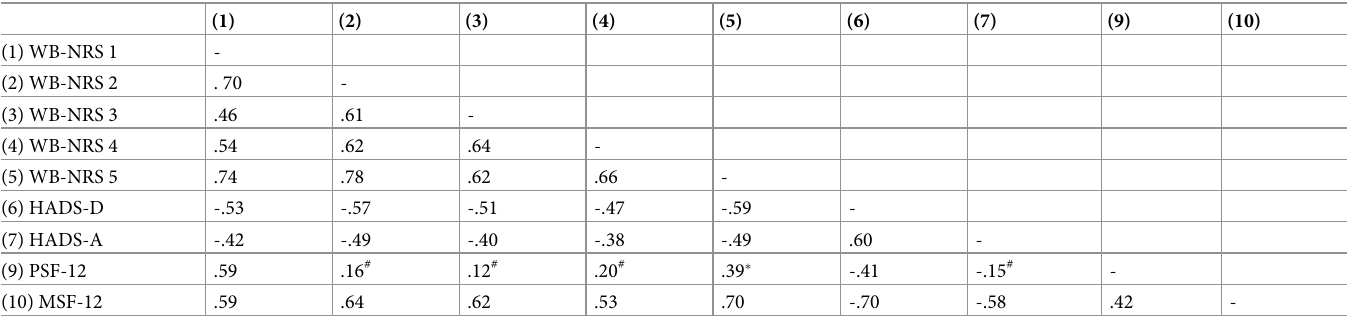
Table 3. Bivariate Bayesian correlates between the Well-being Numerical Rating Scales (WB-NRSs) and the other variables in the study in the clinical